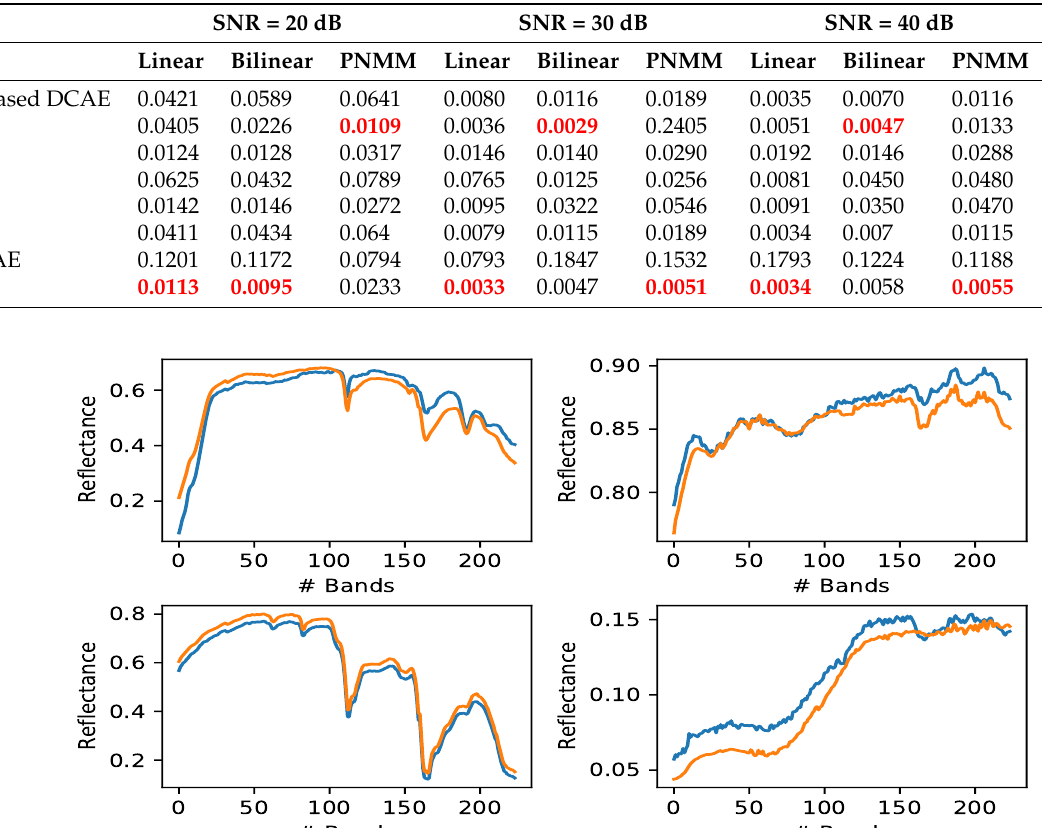
Table 5. Endmember SID comparison of the synthetic data (best results are highlighted in red).